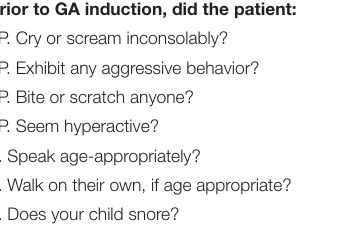
Yes N (%) Healthy N (%) ASD N (%) P -value